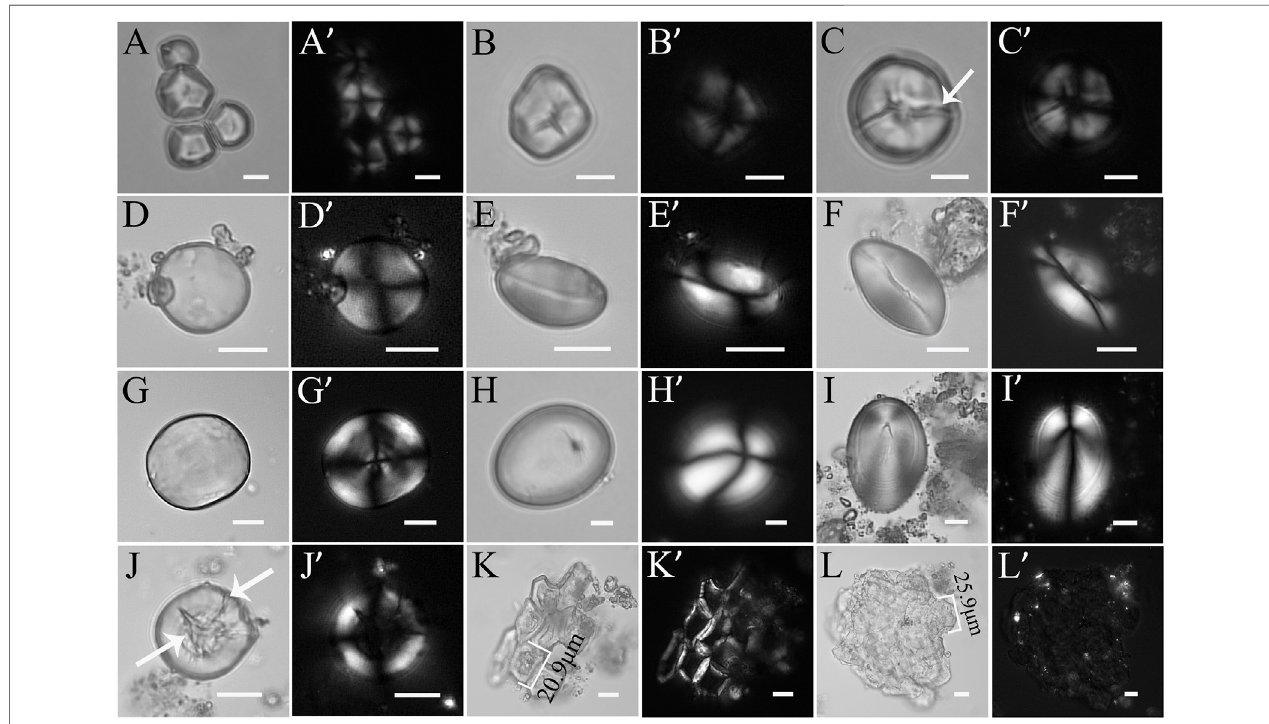
FIGURE 4 | Types of starch grains extracted from 24 human dental calculus at the Lajia site. (A-C 9 ) , Type Ⅰ : (A-B 9 ) , Type Ⅰ intact starch grains; (C,C 9 ) , Type Ⅰ damagedstarchgrains. (D-G 9 ) ,Type Ⅱ : (D-F 9 ) ,Type Ⅱ -Aintactstarchgrains; (G,G 9 ) ,Type Ⅱ -Bdamagedstarchgrains. (H-I 9 ) ,Type Ⅲ ; (J-L 9 ) ,Type Ⅳ : (J,J 9 ) ,Type Ⅳ -A; (K,K 9 ) , Type Ⅳ -B; (L,L 9 ) , Type Ⅳ -C. (A, A 9 -L, L 9 ) , Photos were taken under bright fi eld (left) and polarized light (right). (Arrow indicates damage in starch grains. Scale bar: 10 μ m).